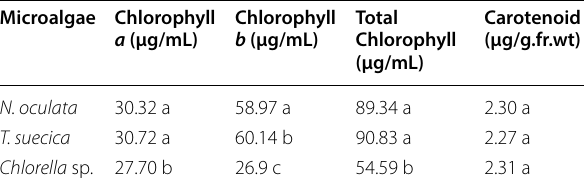
Each column with the same letters indicate not significantly different at p > 0.05